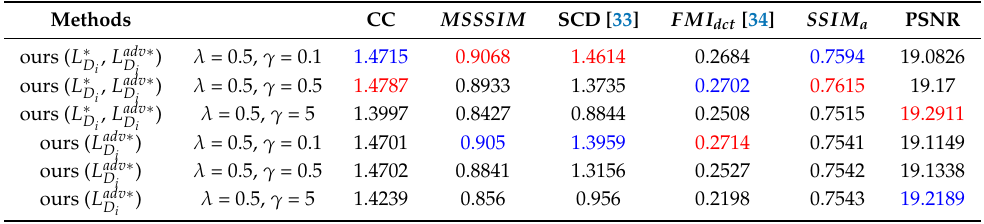
Table 4. The average values of quality metrics for 20 fused images of our private dataset. Different values of λ and γ are used in the loss function. The best values are indicated in red and the second best values are indicated in